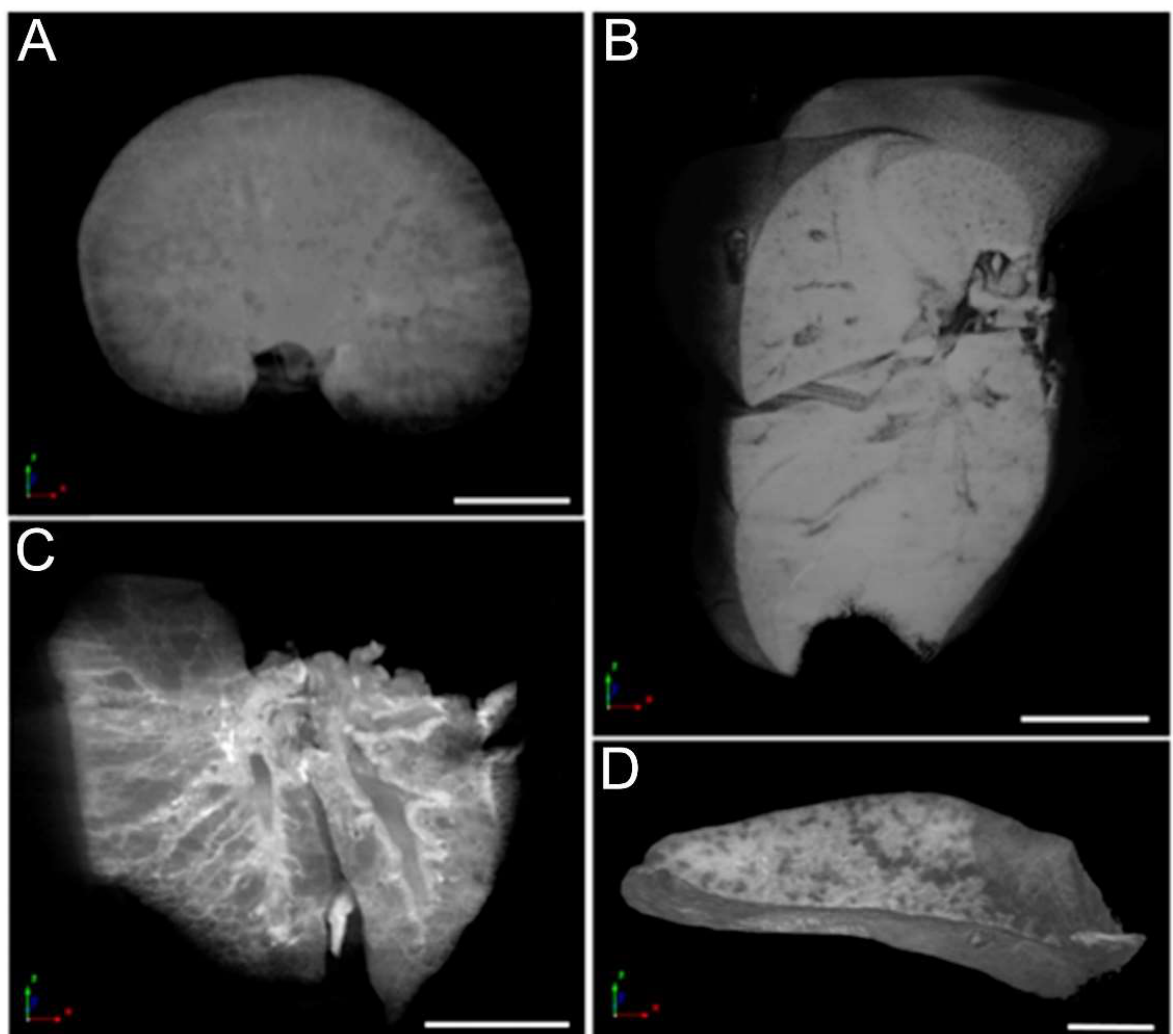
Figure 7. Micro-CT images of ( A ) kidneys, ( B ) liver, ( C ) lungs, and ( D ) spleen of a T5 Group animal. Scale bar = 2.5 mm.